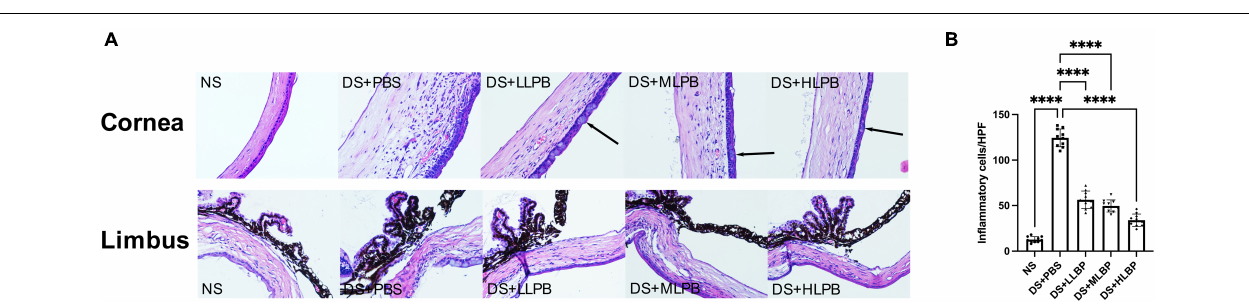
FIGURE 2 | (A) The effects of topical application of LBP on the tear secretion rate on days 3 and 10 after treatment. (B) The effects of topical application of LBP on TBUTs on days 3 and 10 after treatment. Data of tear secretion rate were shown as the mean ± SD. Data of TBUTs were shown as median (IQR). ∗ P < 0.05, ∗∗ P < 0.01, ∗∗∗∗ P < 0.0001.